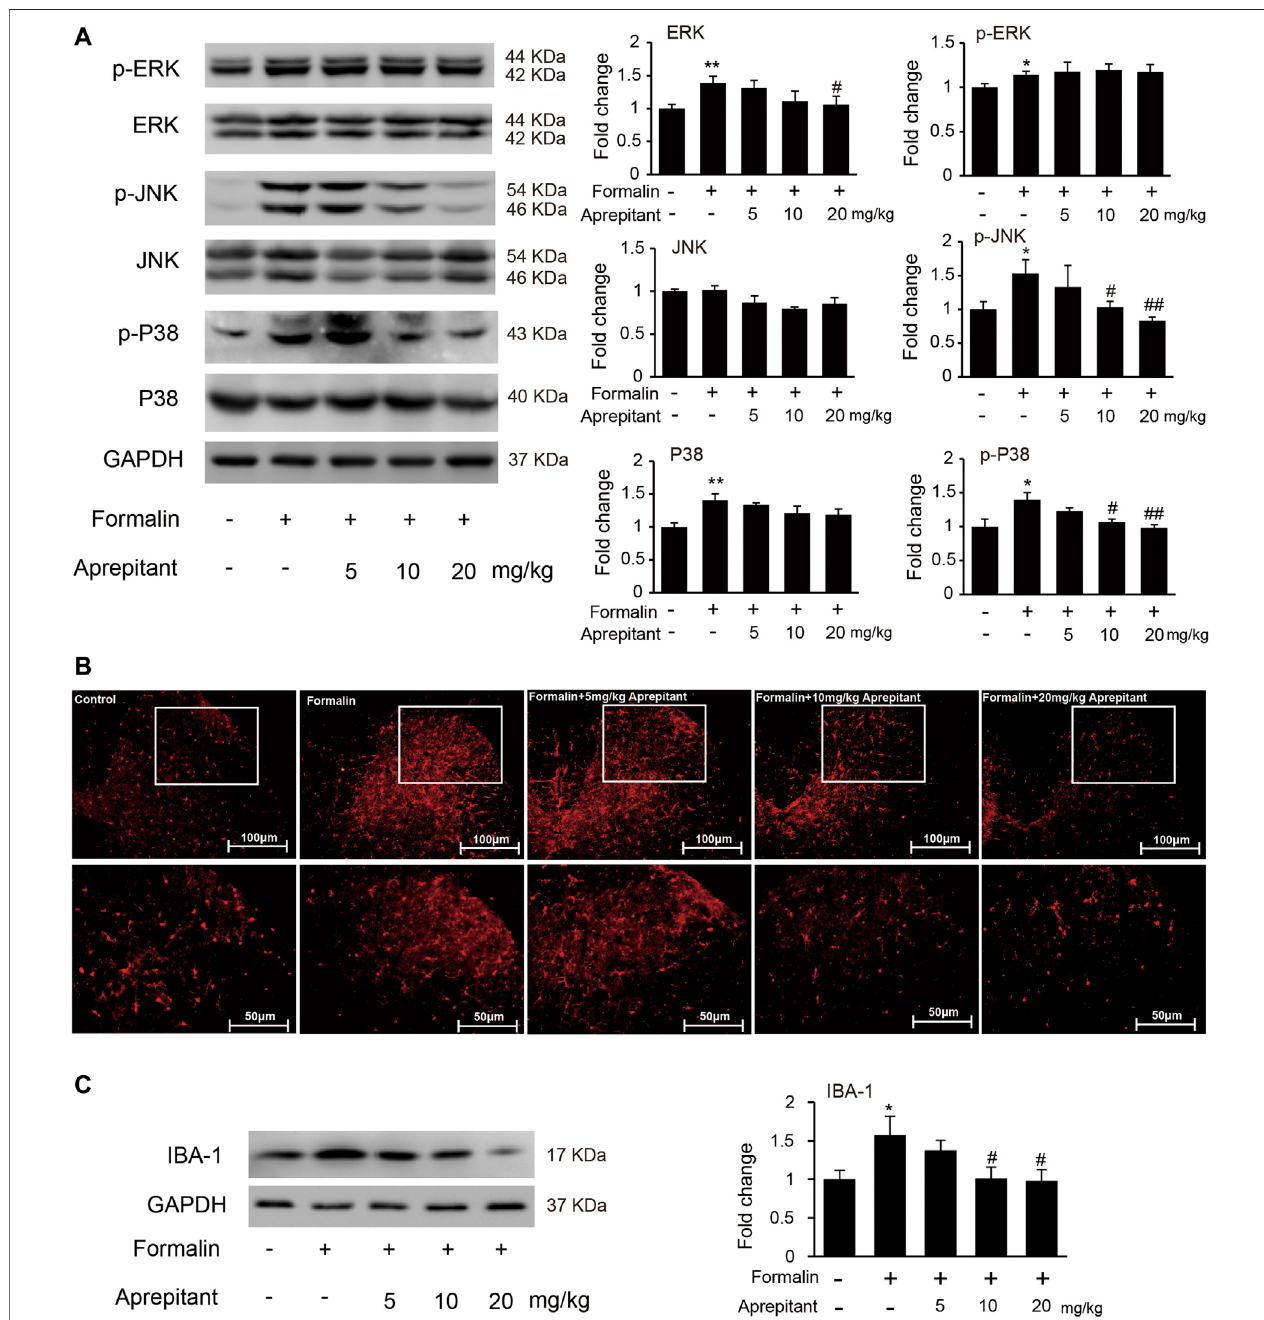
FIGURE 5 | Effects of aprepitant on the phosphorylation of MAPK and microglial activation in spinal cord of mice with formalin-induced in fl ammatory pain. (A) The protein and phosphorylation of ERK, JNK and p38 MAPK in the spinal cord. (B) Confocal images of immunostaining showed the expression of IBA-1 in the spinal cord. (C) Western blotanalysisoftheexpression ofIBA1inthespinalcord( n (cid:1) 4).Dataareexpressed asmean ± SEM.One-wayANOVA, * p < 0.05, ** p < 0.01versuscontrol, # p < 0.05, ## p < 0.01 versus formalin.